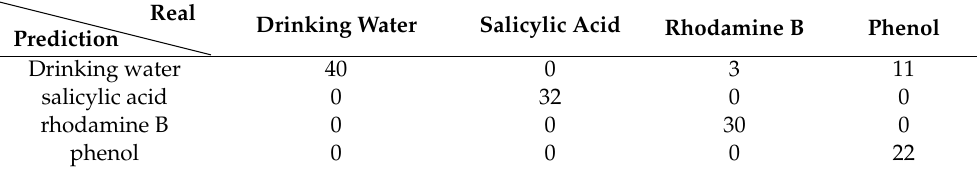
Table 5. Qualitative discrimination results of groups C and D based on the improved algorithm Prediction